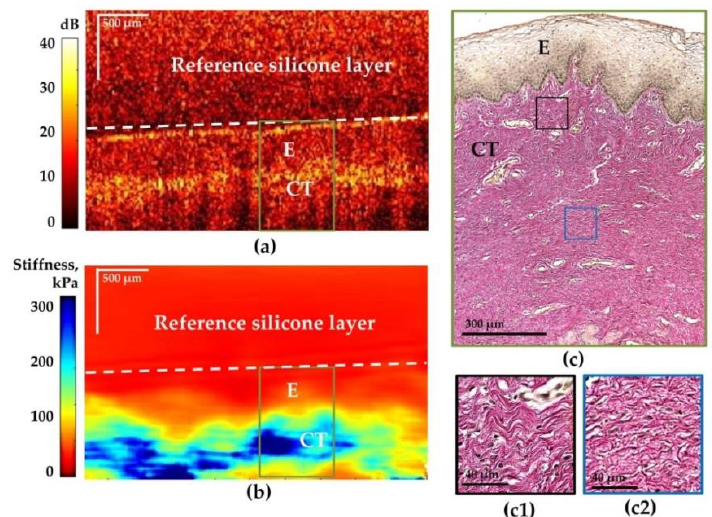
Figure 4. Representative depth-wise structural OCT ( a ) and C-OCE ( b ) images of stages I–II vaginal wall prolapse after Nd:YAG laser preoperative treatment and the corresponding histology ( c – c2 ). The right column ( c , c1 , c2 ) is the histological slide stained with Van Gieson’s, where ( c )—the overview image shows a dense and homogeneous structure of the submucosal connective tissue without slit-like spaces ( × 100); the black square ( c1 )—the subepithelial region of the submucosal connective tissue consists of densely arranged collagen bundles ( × 1000); and the blue square ( c2 )—the deep area of the submucosal connective tissue, the tissue becomes even denser, and there are no spaces between the bundles ( × 1000). There is a well-organized two-layer architecture with a sharp interface between nonkeratinizing stratified squamous epithelium and underlying connective tissue. The white dotted lines in the OCT and C-OCE images are the boundary of the transition between the calibration silicone layer and the tissue under study. The green rectangle in the OCT and C-OCE images is the area corresponding to the histological image in ( c ). Abbreviations: E—epithelium, CT—connective